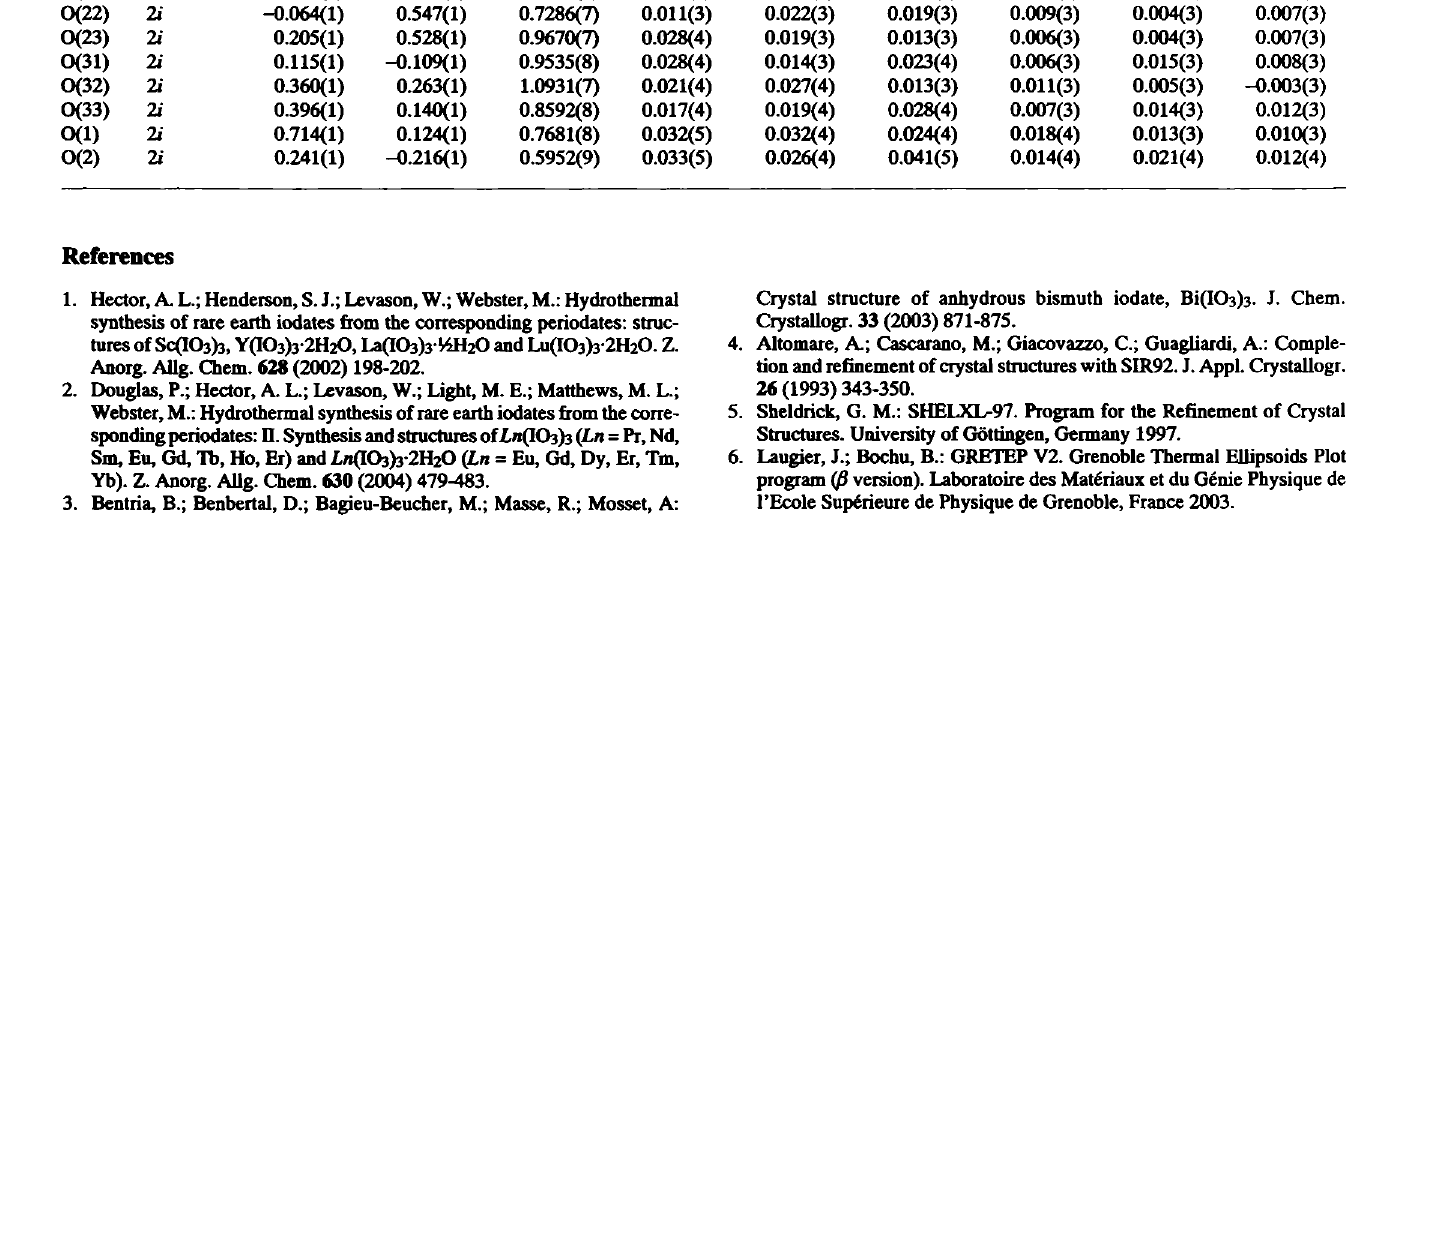
Table 2. Atomic coordinates and displacement parameters (in Ä 2